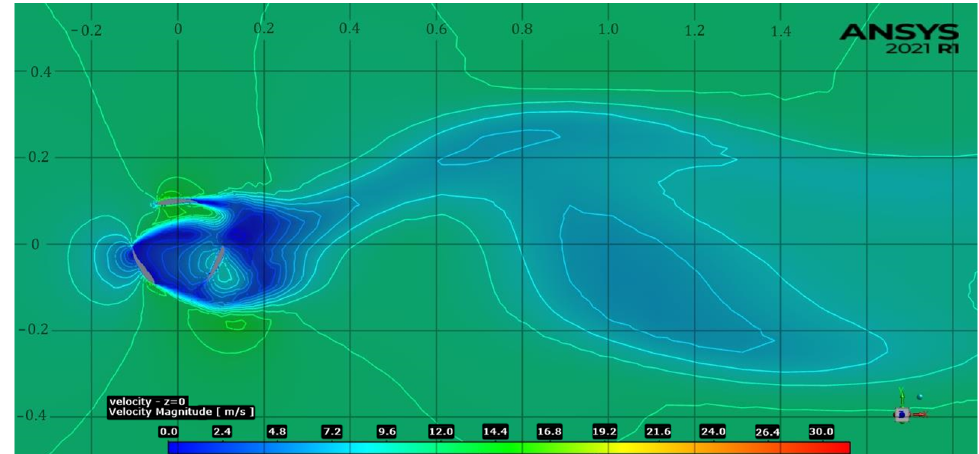
Figure 21. Velocity contour at 12 m/s wind speed and TSR of 0.1, with enlarged legend.